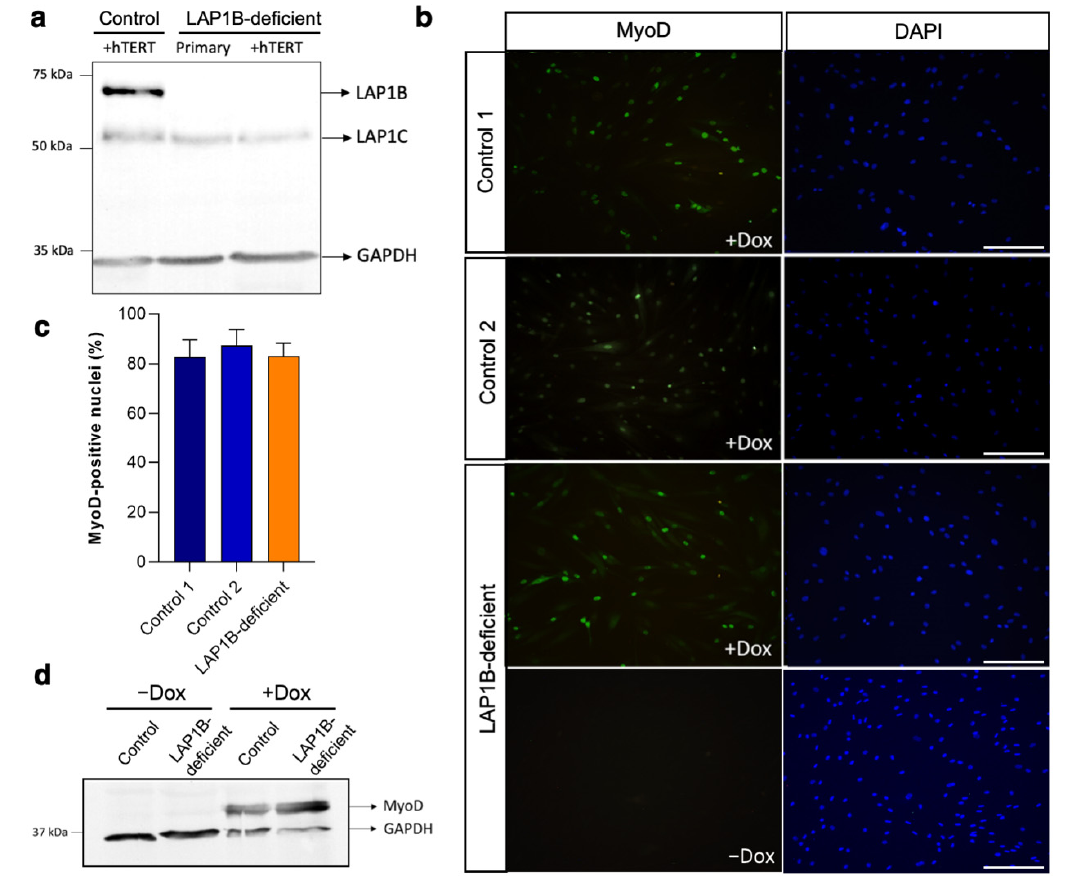
Figure 1. Immortalization and myoconversion of the control and patient-derived LAP1B-deficient fibroblasts. ( a ) Protein expression of LAP1 isoforms in the control immortalized (+hTERT) and patient-derived primary and immortalized (+hTERT) fibroblasts, as shown after Western blotting; GAPDH was used as a loading control. ( b ) Immunofluorescence staining of MyoD in the control and LAP1B-deficient fibroblasts at 18 h after induction with doxycycline (+Dox) supplementation in a differentiation medium; the nuclei are stained with DAPI. No MyoD induction was detected in the cells maintained in the differentiation medium without doxycycline supplementation ( − Dox). Scale bar: 20 μ m. ( c ) Percentage of MyoD-positive nuclei in the control and LAP1B-deficient cells after 18 h of doxycycline-mediated MyoD induction. ( d ) Protein expression of MyoD in the control and LAP1B-deficient cells before ( − Dox) and 48 h after (+Dox) doxycycline supplementation in the differentiation medium, as shown after Western blotting. GAPDH was used as a loading control.